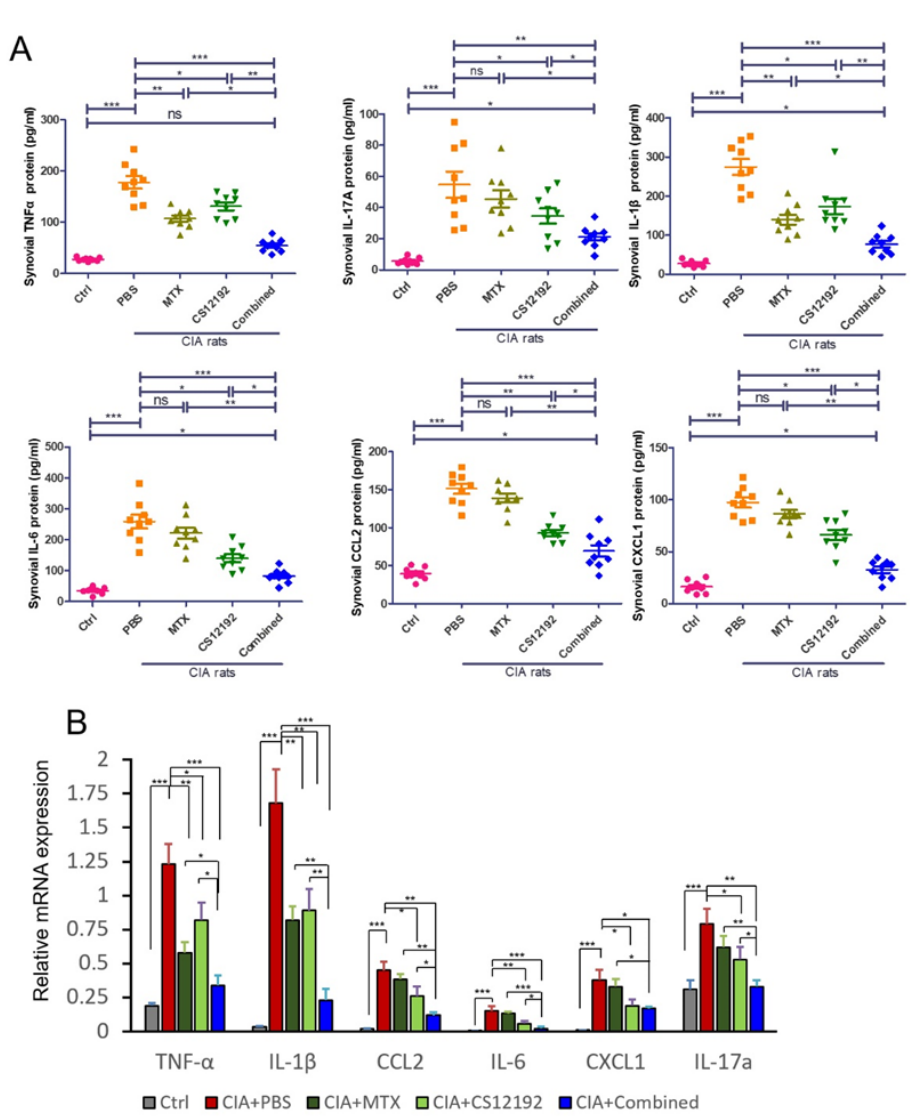
Figure 5. Therapeutic effects of MTX, CS12192, or the combination of CS12192 and MTX treatments on expression of pro-inflammatory cytokines in synovial fluids by ELISA and joint tissues by real-time PCR on day 28. ( A ) ELISA measurements of TNF- α , IL-1 β , CCL-2, IL-6, CXCL-1, IL-17A levels in synovial fluids in CIA rats receiving different treatments. Each dot represents one rat. ( B ) Real-time PCR detects mRNA expression of TNF- α , IL-1 β , CCL-2, IL-6, CXCL-1, IL-17A in the synovial tissues of CIA rats. Each bar represents the mean ± SEM from 10 animals per group * p < 0.05; ** p < 0.01; and *** p < 0.001 as